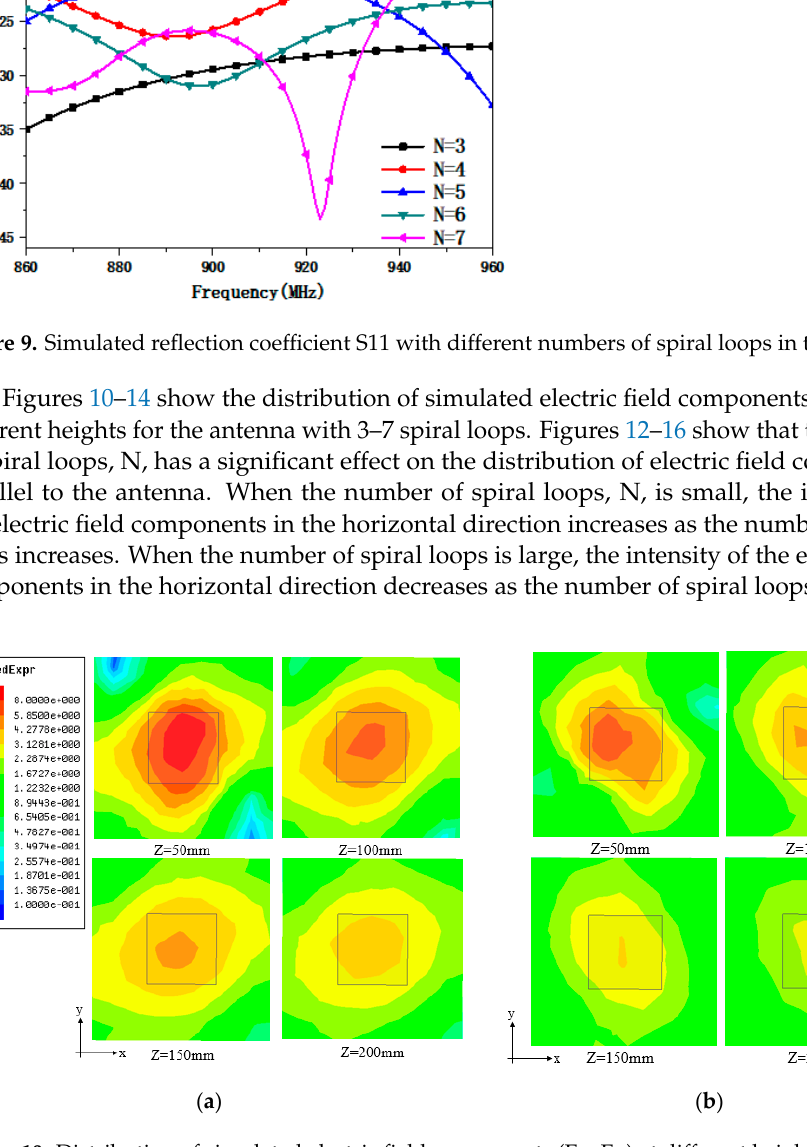
( b ) Figure 11. Distribution of simulated electric field components (Ex, Ey) at different heights with four spiral loops: ( a ) Ex distribution and ( b ) Ey distribution.